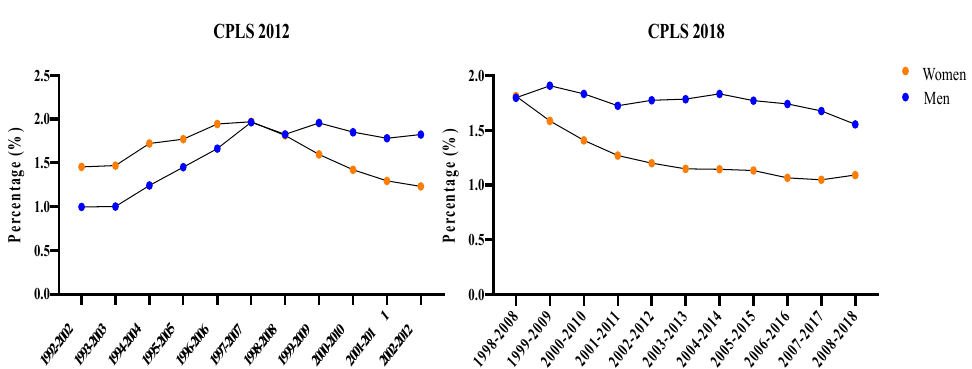
Figure 3. Variation in the average days contributed by periods of 10 years in people aged 20 to 30 years, Spain (1992–2018). Source: Our own elaboration from the Spanish CPLS 2012 and 2018.